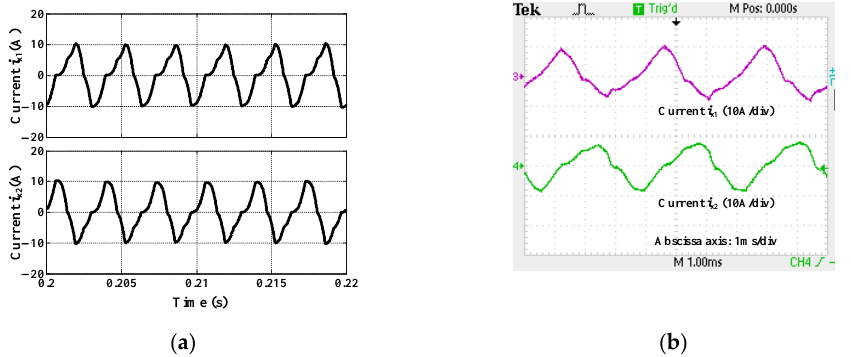
Figure 16. Current through the primary winding of the injection transformer. ( a ) Simulation result. ( b ) Experimental result.